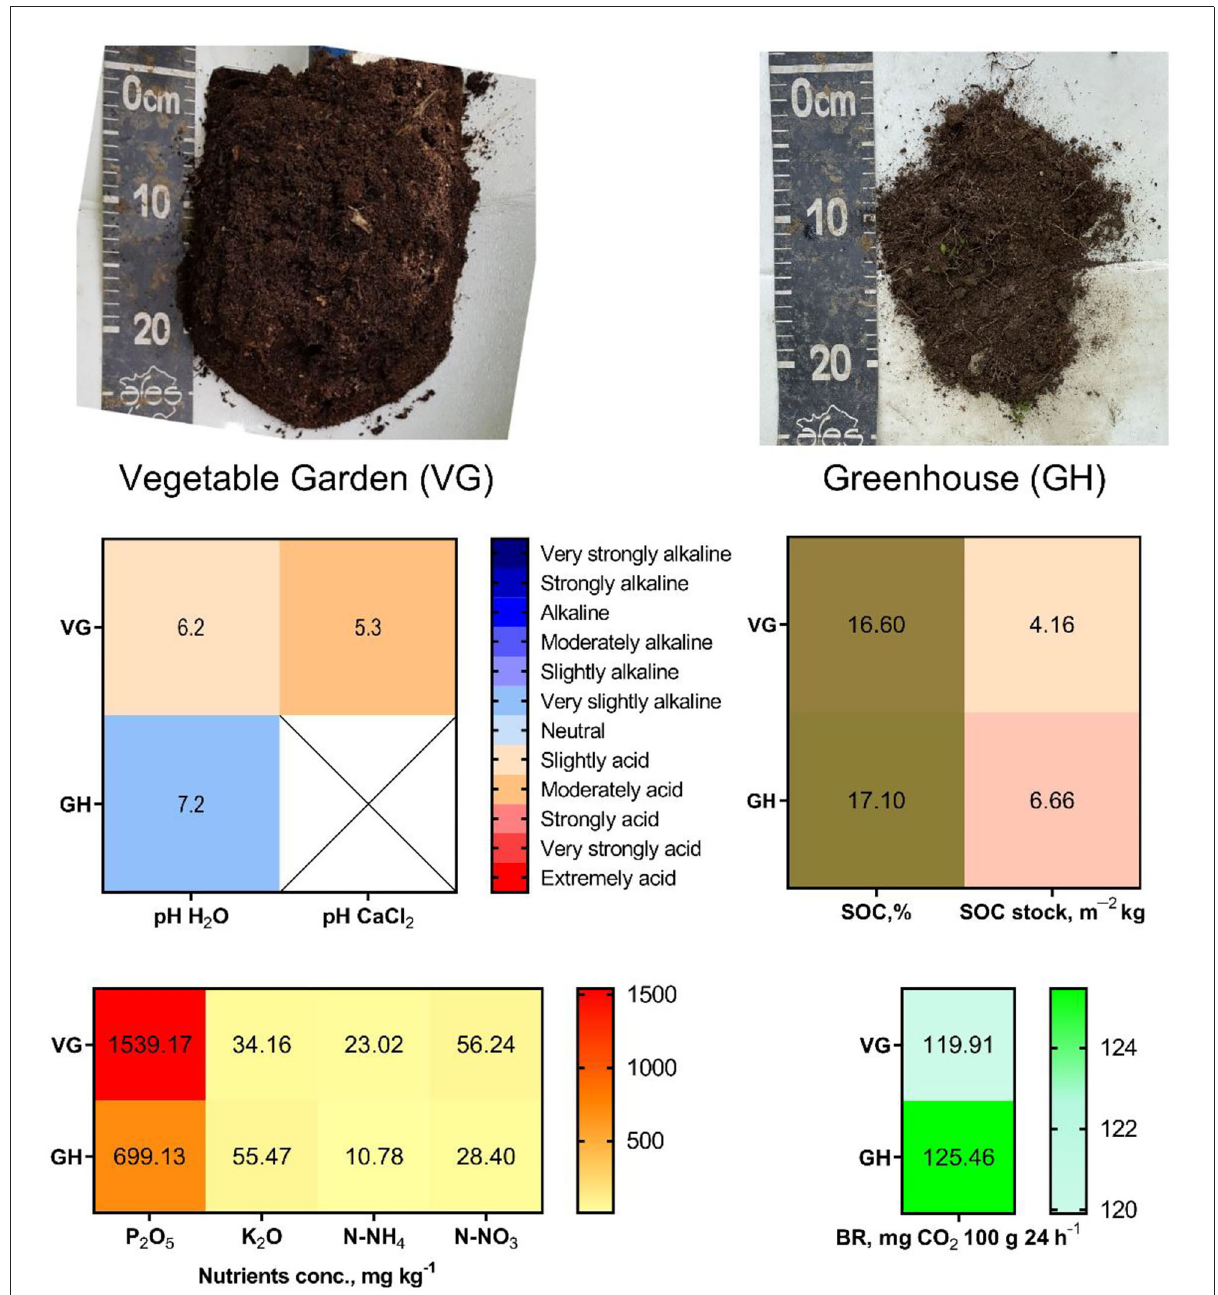
FIGURE6 Main soil properties in greenhouse and vegetable garden. Soil name: Hortic Anthrosols (WRB, 2015).